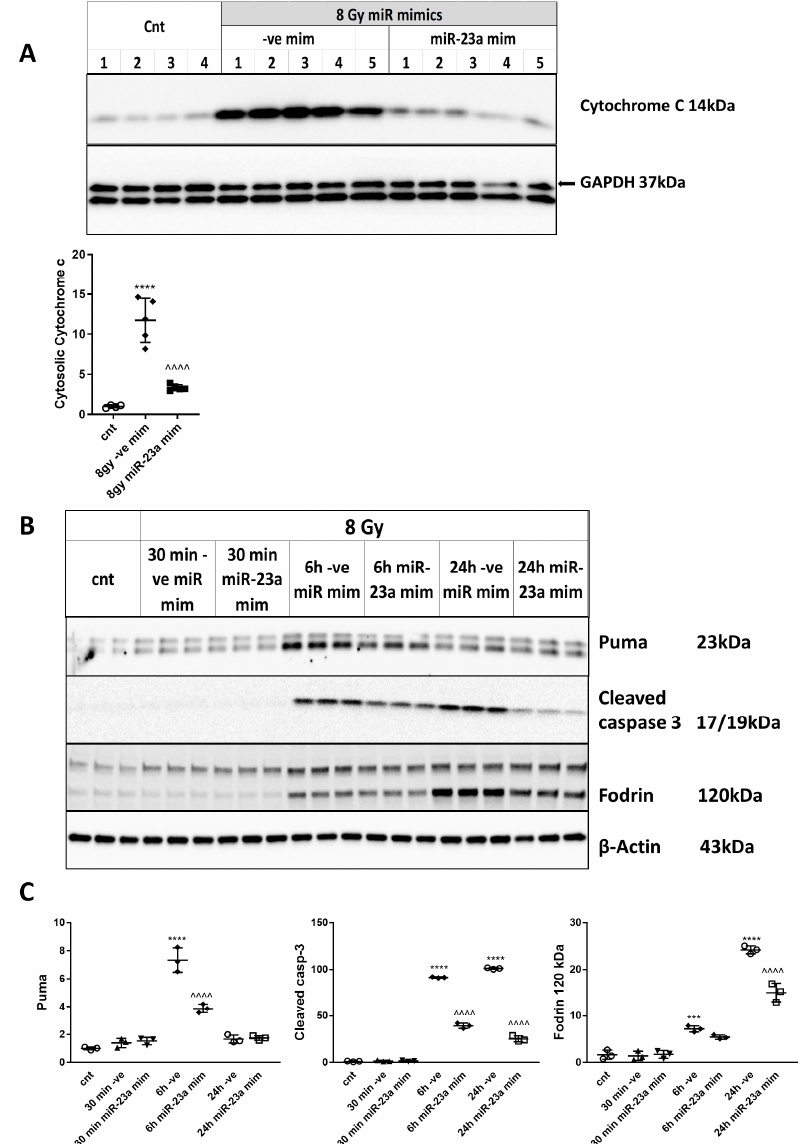
Figure 8. miR-23a-3p attenuates caspase-dependent neuronal apoptosis after irradiation. Neurons were transfected with miR-23a-3p mimics and miR-ve mimics and collected at 6 h after 8 Gy irradiation. Cytosolic fractions were separated by SDS-polyacrylamide gel and immunoblotted with antibodies against cytochrome c and GAPDH. Image of a representative experiment ( A ). Protein levels were quantified by densitometry, normalized to an approximately 37 kDa band of GAPDH, and presented as a fold change compared to control levels, n = 4 for control, n = 5 for other groups in each experiment. The experiment was repeated three times. Data represent mean ± SD. Significance assigned by one-way ANOVA and Tukey post-hoc analysis, **** p < 0.0001 vs. control RCNs; ˆˆˆˆ p < 0.0001 vs. 8 Gy + miR-ve mimic. RCNs were transfected with miR-23a-3p mimics, and negative control mimics before irradiation. Neurons were collected at 30 min, 6 h, and 24 h after 8 Gy irradiation. Whole-cell lysates were separated by SDS-polyacrylamide gel and immunoblotted with antibodies against Puma, α -fodrin, and cleaved caspase-3. Image of a representative experiment. ( B ). Protein levels were quantified by densitometry, normalized to β -actin, and presented as fold change compared with untreated control levels ( C ). The experiment was repeated 3 times with similar results, n = 3 / group in each experiment. Data represent mean ± SD of one-way ANOVA and Tukey post hoc analysis, *** p < 0.001, **** p < 0.0001 vs. control RCN, ˆˆˆˆ p < 0.0001 vs. negative control mimic transfected cells (-ve mim)